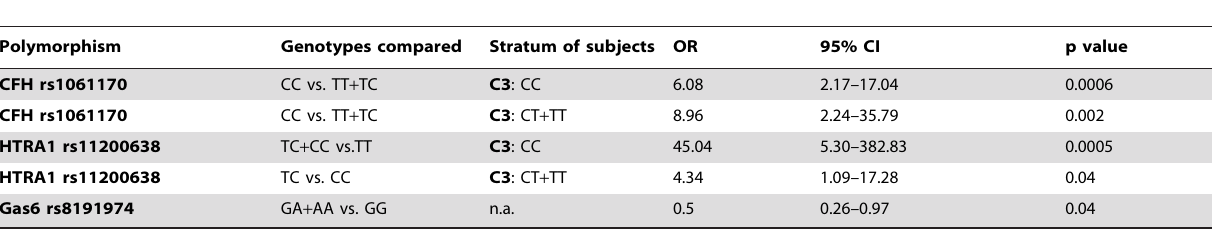
Table 4. Polymorphisms showing significant association with wet AMD using multiple logistic regression.